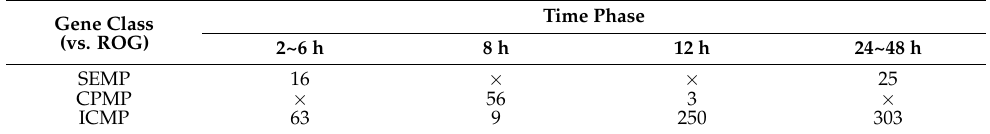
ROG, rest of genome. Table 4. Statistically significant ( p ≤ 0.05) numbers of associated biological process terms of each gene class in each time phase.